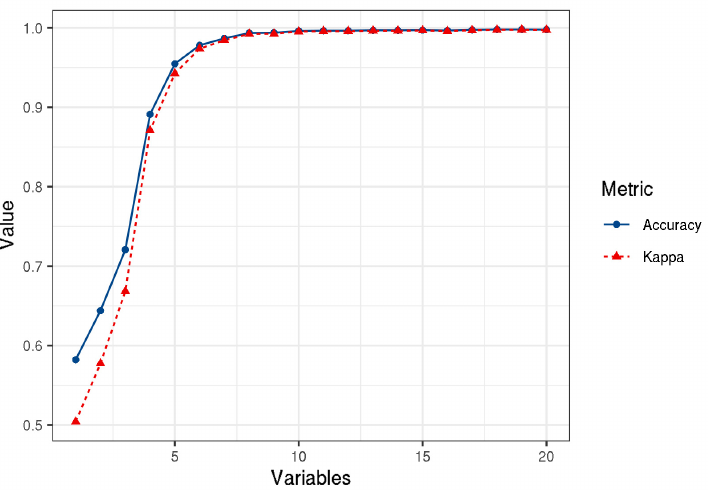
Figure 2. Relationship between classifier accuracy and the number of variables included.